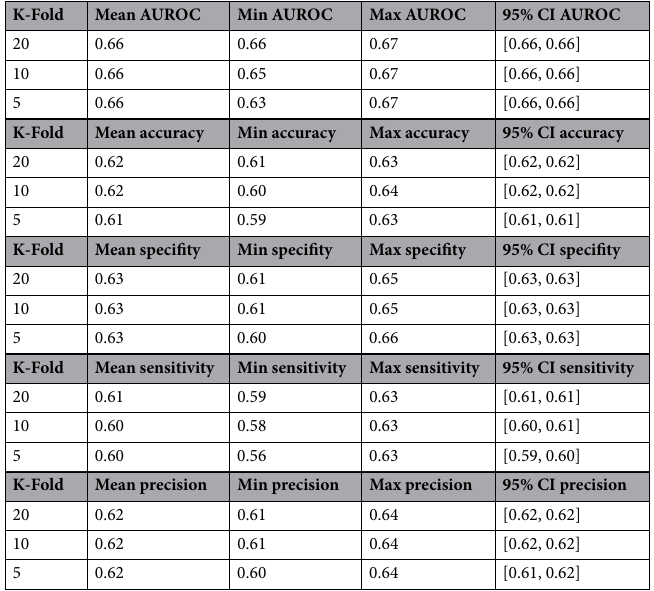
Table 2. Results from the PLS-DA analysis of spectrum region of 1490–1180 cm −1 . Averaged results from the PLS-DA model k-fold cross-validation predictive ability repeated 100 times with k-fold values 20, 10 and 5. For each mean AUROC value the P-value was P < 0.001, and the P-values were calculated by using test 1 according to Ojala and Garriga 22 . The number of latent variables were set to 13, as it was yielding the best performance in predictive ability. There were 558 negative and 558 positive nasopharyngeal swab samples (dissolved into the viral transport medium and inactivated by adding viral lysis buffer liquid) measured with ATR-FTIR spectroscopy. Every sample was measured three times. The measured samples were preprocessed before PLS-DA, by applying spectrum truncation to the spectrum region of 1490–1180 cm −1 , vector normalization and spectrum averaging to create a one average spectrum for every measured nasopharyngeal swab